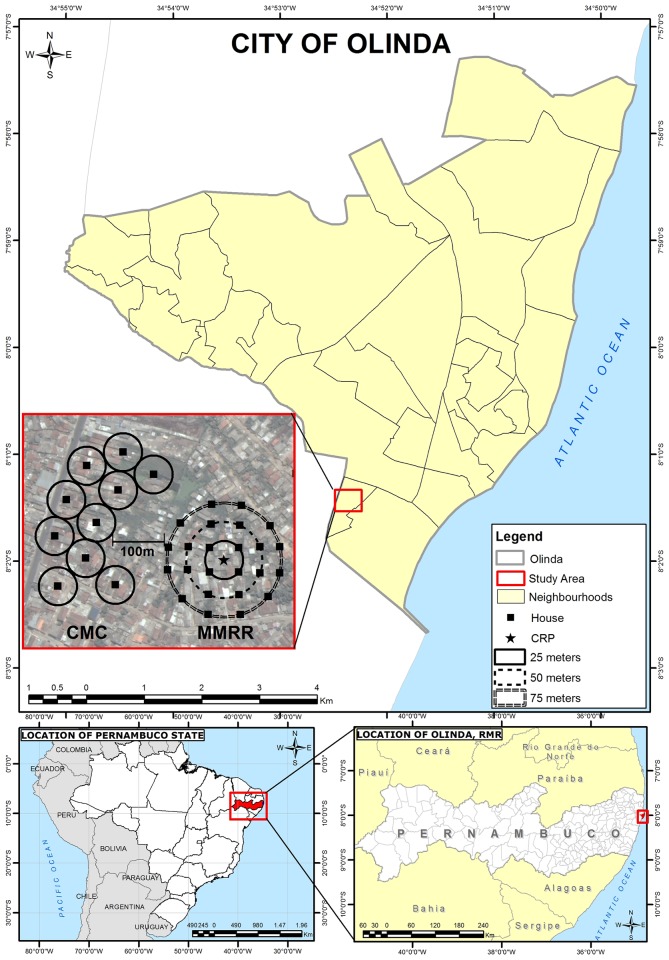
Map of city of Olinda, Recife Metropolitan Region (RMR), Pernambuco State, Northeastern Brazil, and planned study sites within Sítio Novo: Collection method comparison (CMC); mosquito mark release recapture (MMRR); 100m buffer zone.